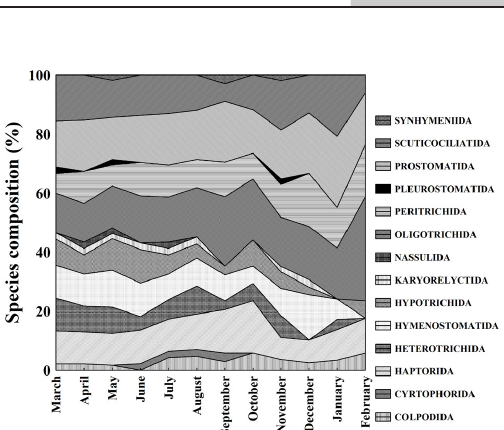
Figure 4. Composition by order (%), registered in the analysed months at Guaraná